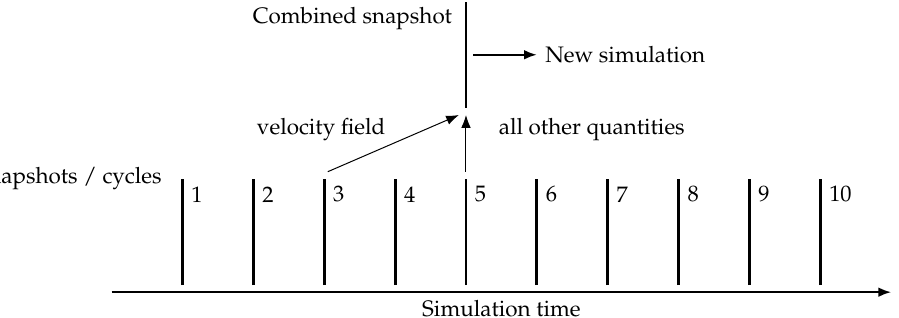
Figure 1. One possible combination of restart files: Here, the flow field is extracted from the third cycle and combined with all other quantities of the fifth cycle. The simulation then starts at the time when the fifth snapshot was